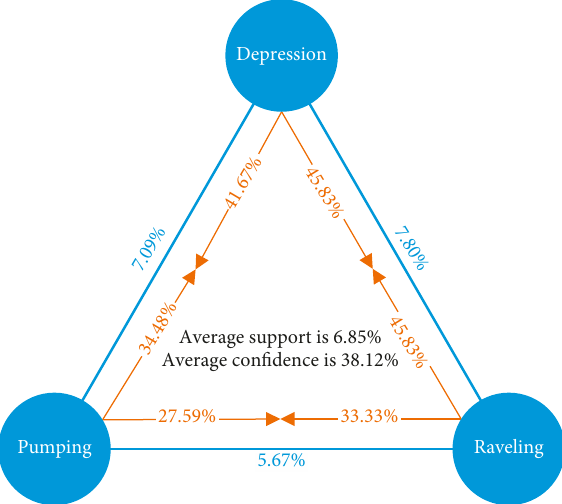
Figure 8: Relationships between depression, pumping, and